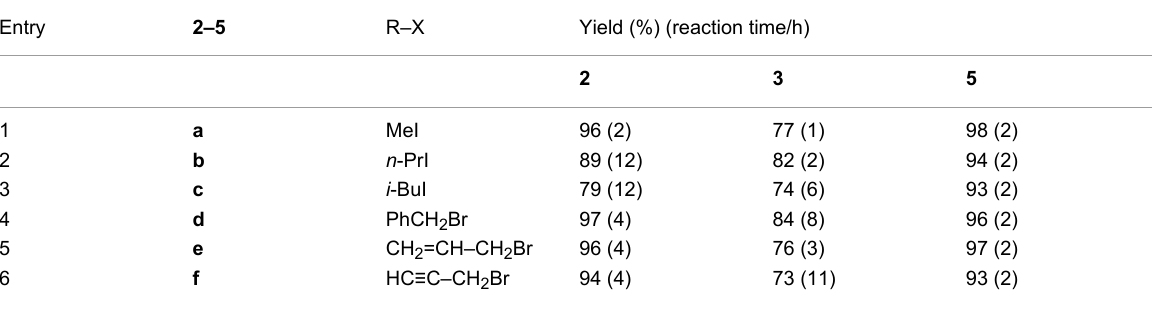
3a and the corresponding amide product 5a by X-ray diffrac- tion measurements (Figure 1 and Table 2) [18]. The observed oxime stereochemistry ( Z ) is possibly due to (putative) steric repulsion between the two bulk y α -substituents (R and trioxa- adamantyl) and the hydroxy group in the alternative E isomer.